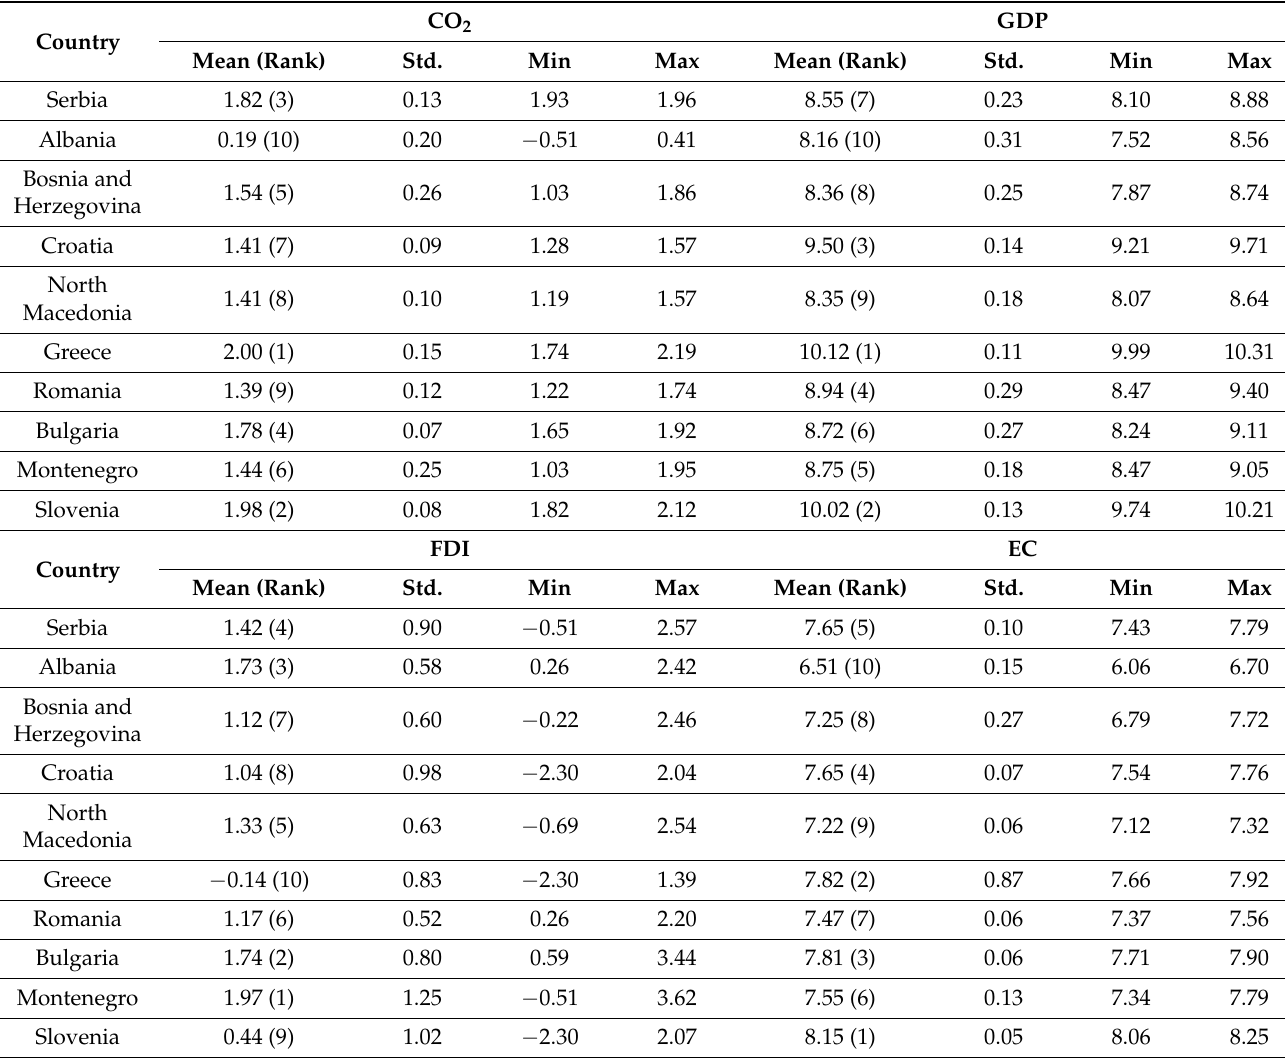
Table 3. Descriptive statistics with mean ranking.